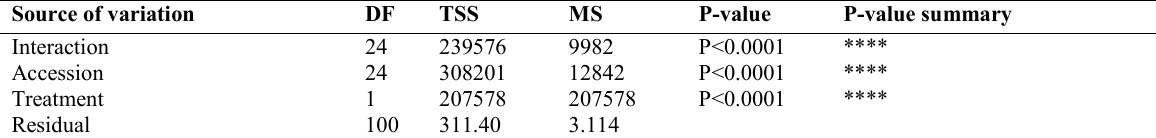
Table 3. Analysis of variance for NCED1 expression profile under control (A) and drought stress (T) conditions. Source of variation